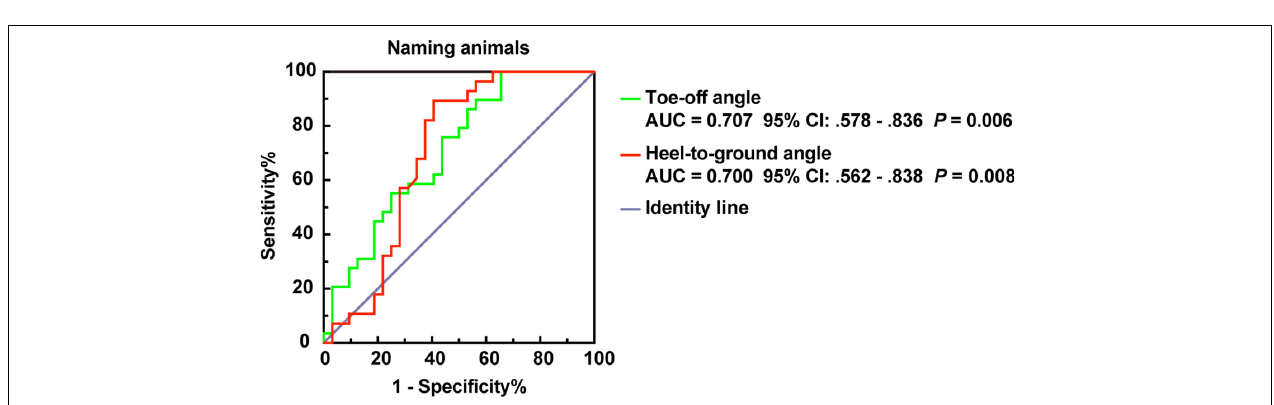
FIGURE 5 | ROC plot for ToA and HtA distinguish PSD and AD of dementia subtypes in the naming animals-task gait test. AUC, area under the curve; CI, confidence